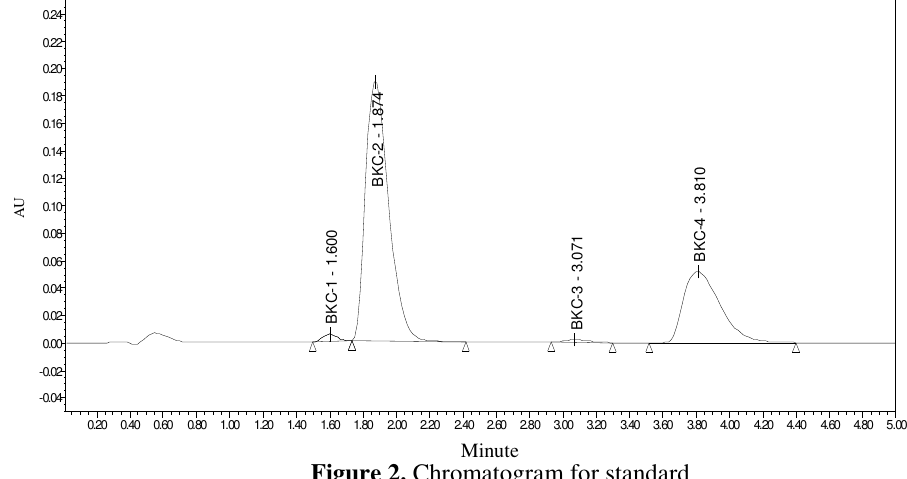
Figure 2. Chromatogram for